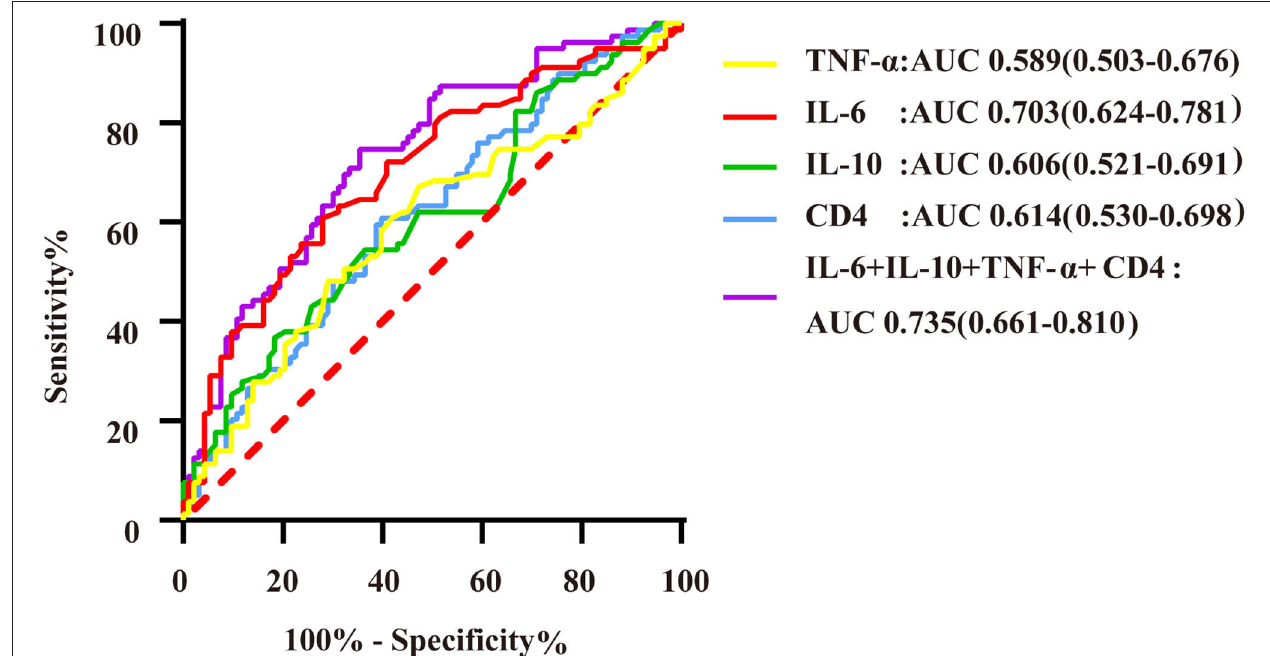
FIGURE 5 | ROC curves of immunoinflammatory biomarkers predicting DS > 70% of the target vessel. AUC indicates the area under the ROC curve. The yellow curve represents the ROC curve of TNF- α ; the red curve represents the ROC curve of IL-6; the green curve represents the ROC curve of IL-10; the blue curve represents the ROC curve of CD4 + T lymphocytes; and the purple curve represents the ROC curve of markers of immuno-inflammatory